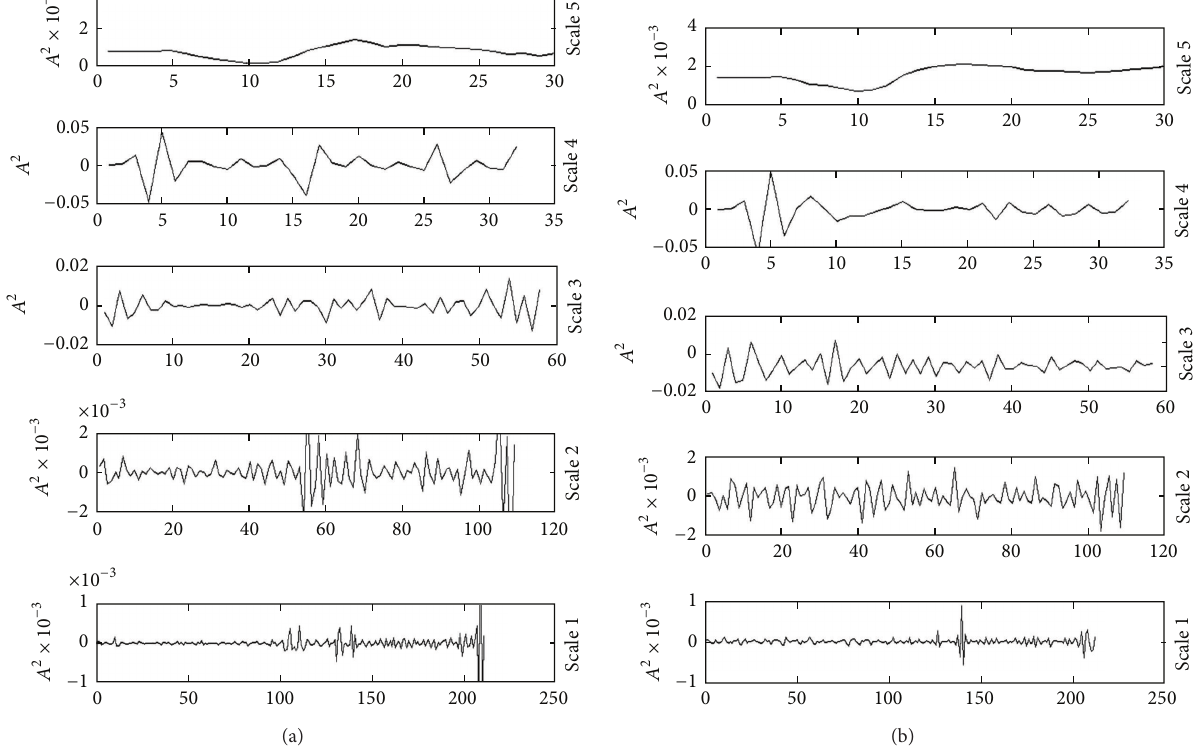
Figure 5: Results of the multiresolution decomposition for the two Mnium species. FTIR spectra with DWT. (a) Mnium laevinerve (9) and (b) M. marginatum